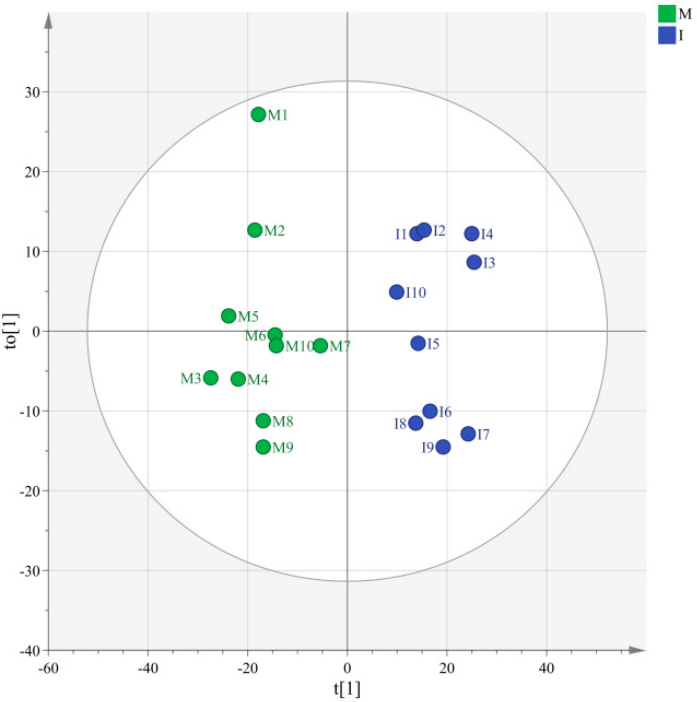
Figure 2. Effects of monoculture and intercropping patterns on the component numbers and relative contents of volatile substances in different categories (PLSDA). See Figure 1 for treatment